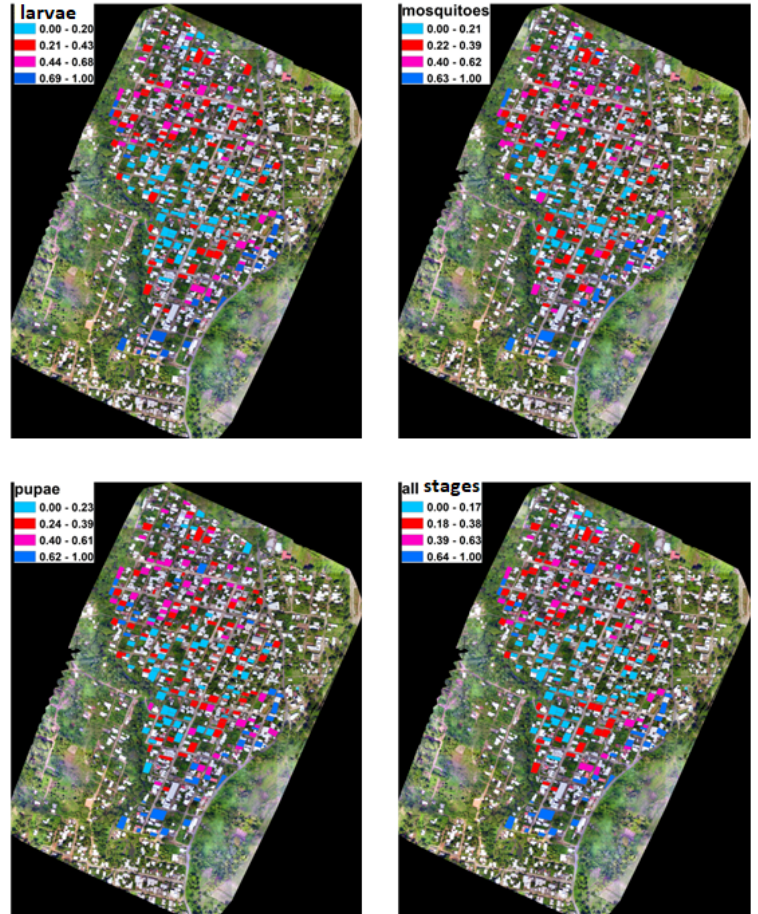
Figure 8. House-level risk index obtained with PLS for different response variable Y . Maps shows the geographic distribution of